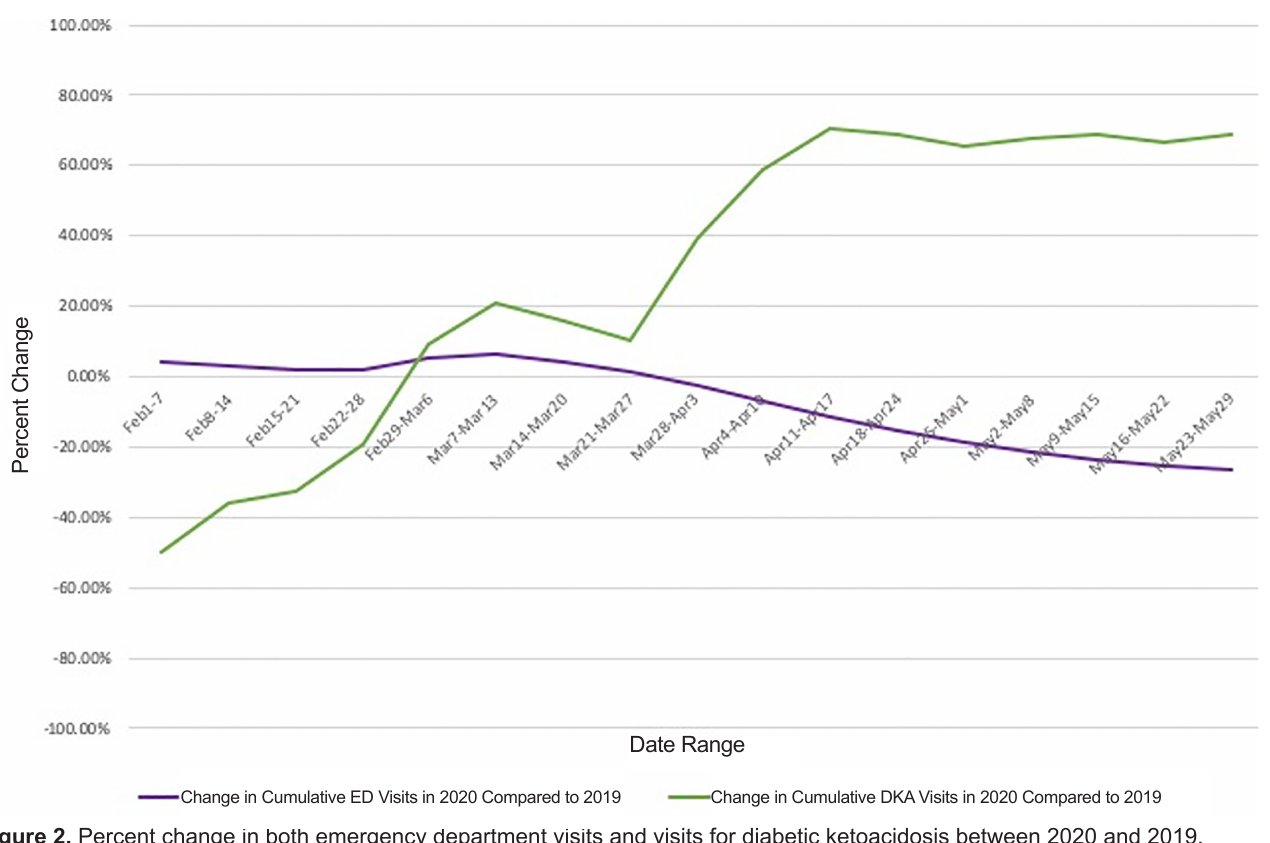
Figure 2. Percent change in both emergency department visits and visits for diabetic ketoacidosis between 2020 and 2019. ED, emergency department; DKA, diabetic